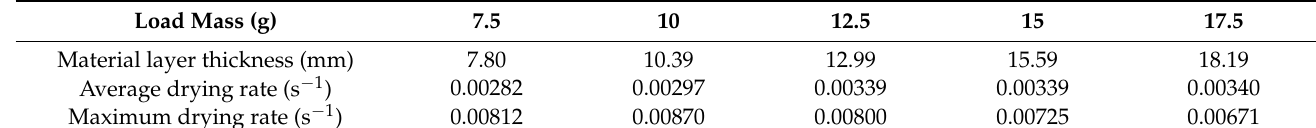
Figure 9. Effects of load mass on the ( a ) moisture ratio and ( b ) drying rate of CRES in the microwave drying process. Table 5. Variations of microwave drying characteristics of CRES with load mass.